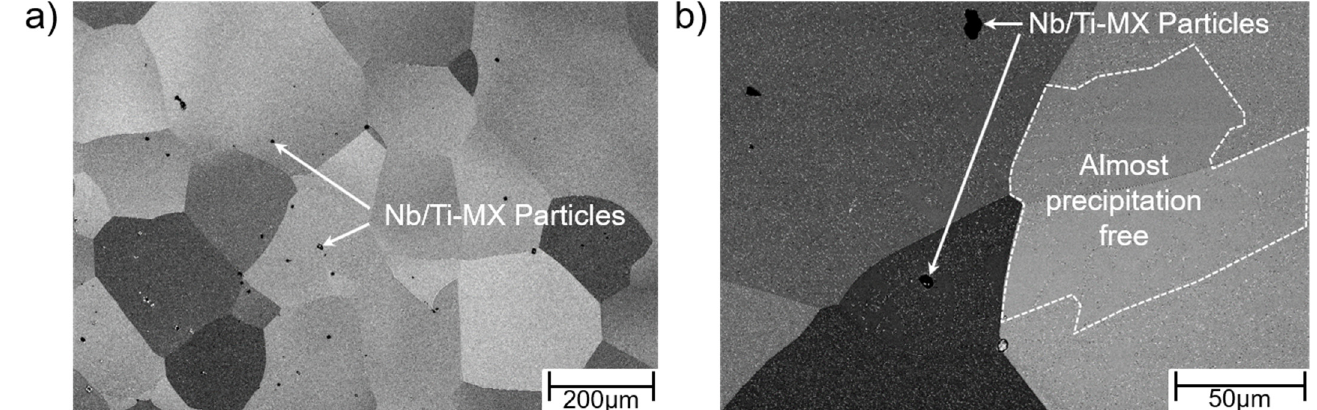
Figure 18. SEM investigations demonstrate ( a ) undesirable Nb/Ti-MX particles in Crofer ® 22H (PA) sheet I and ( b ) almost Laves phase particle-free regions within the matrix, which have no additional crack-inhibiting properties except for solid solution strengthening and thus strongly impact the crack propagation